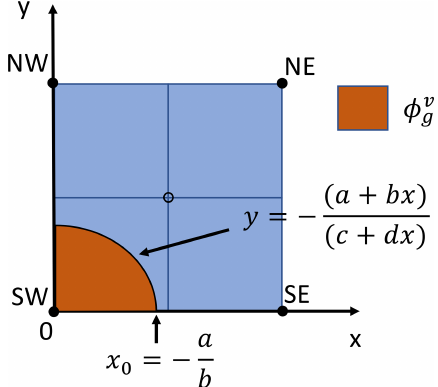
Figure 2. Example computation of the grounded area fraction in the staggered grid cell defined by four cell centers (filled circles) adja- cent to a cell vertex (hollow circle). Based on a flotation condition, Eq. (5), the lower left cell center (SW) is grounded, and the other three cell centers (SE, NE, NW) are floating. The curved black line is the grounding line, where f float (x,y) = a + bx + cy + dxy = 0, with coefficients given by Eq. (8). The grounded area fraction, φ v g , is found by integrating the area between the grounding line and the SW cell center, which lies at the origin ( 0 , 0 ) in a local coordinate